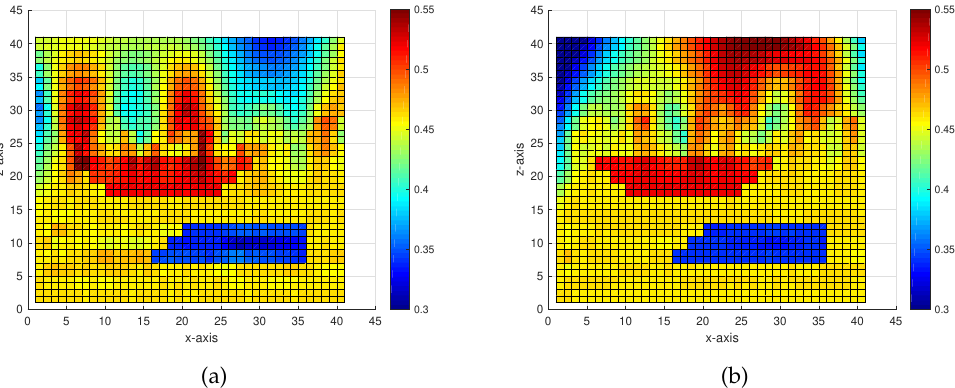
Figure 4. The inversion results by MGCS with different noise levels; ( a – d ) are the identified porosity images with 30 dB, 25 dB, 20 dB and 15 dB Gaussian noises respectively.